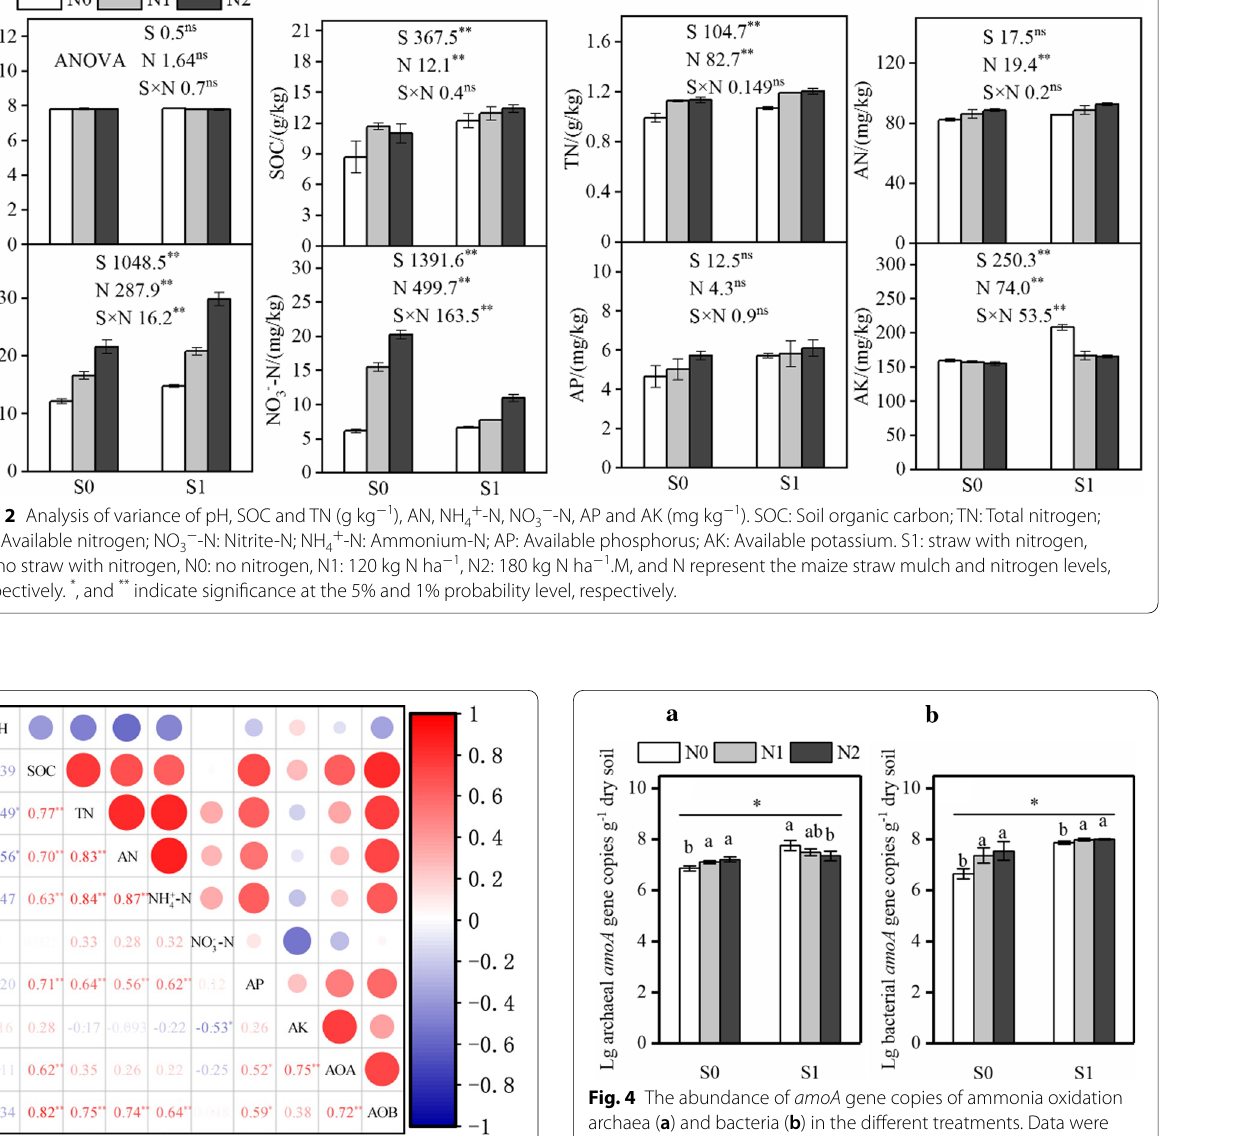
Fig. 3 Pearson correlation analyses of soil properties and amoA gene abundances of ammonia oxidation archaea (AOA) and bacteria (AOB). Red represents a positive correlation, blue represents a negative correlation, and the larger the circle, the darker the colour, the stronger the correlation. SOC: Soil organic carbon; TN: Total nitrogen; AN: Available nitrogen; NO 3 − -N: Nitrite-N; NH 4 + -N: Ammonium-N; AP: Available phosphorus; AK: Available potassium. * , and ** indicate significance correlation at the 5% and 1% probability level, respectively